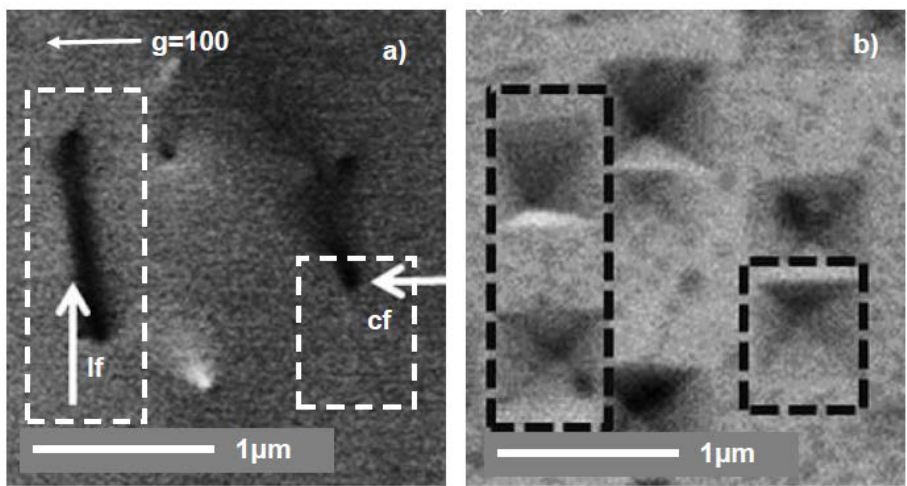
Figure 29. Image of the dislocations of pre-etched SrTiO 3 crystal (SEM photography ( b )) using channeling contrast imaging (ECCI photography ( a )) shows a correlation (marked by dashed line) between the position of the etch pits and the electronic contrast. Adapted from [200], for the details please see mentioned reference.